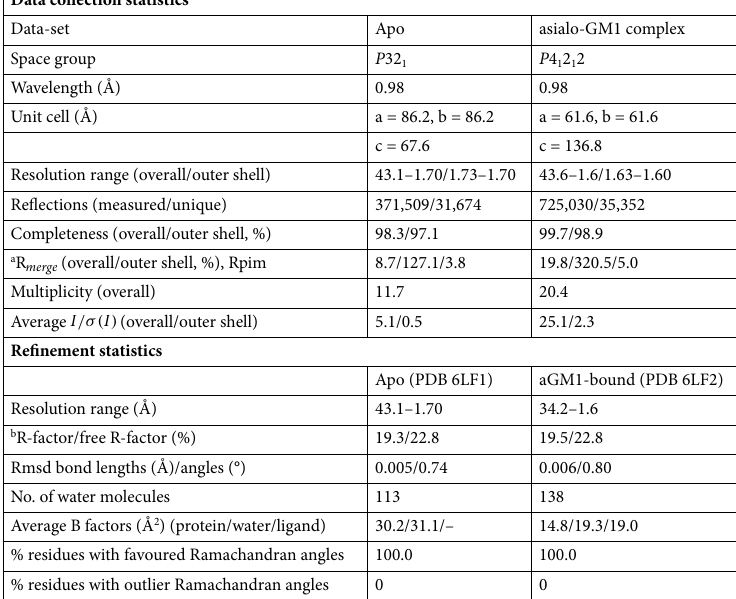
too small for PISA 28 to predict a stable dimer with confidence. Contacts between the two subunits are listed in STable 1. Compared to MytiLec, SeviL is truncated at the C-terminus by 13 residues. These 13 residues form part of the dimer interface in MytiLec, so the two subunits of SeviL are held together by a quite different set of interactions. β -trefoil lectins are often found to be dimeric, but the dimer interactions differ widely in buried surface area and orientation 29 . Within the apo crystal structure, a crystal contact is formed with Arg 26 of the B chain approaching within 3.6 Å of its symmetry mate. Two nearby balls of electron density were modelled as chloride ions, which would counter the repulsive charge on the two residues (SFigure 2). One chloride ion sits in a hydrophobic pocket formed by Phe 21, Phe 32 and Tyr 37; it comes within 3 Å of the side-chain of Asp 39, which also lies close to Arg 26 from the neighbouring molecule. No chloride ions were modelled near the A subunit, and it appears this interaction is unique to the crystal form, which was crystallised at pH 3.5. Comparison with other trefoil lectins. Although SeviL shows only weak sequence similarity to known structural models, using DALI 30 to find structural homologues in PDB with the model of the Sevil subunit yielded a number of significant matches. The closest (with a Z-score of 18.2) is lectin LSL from the mushroom Laetiporus sulphureus (PDB 1W3A) 31 . This is a hexameric pore-forming lectin with an N-terminal β -trefoil domain. The γ subdomain binds the non-reducing galactose (Gal) moiety of lactose. A sequence alignment of SeviL and its closest structural homologues is given in SFigure 3. DALI identified 24 structures with a Z-score of 15 or higher, which are mainly listed as lectins or proteins of unknown function. Several are reported to be insec- ticidal and one is actinohivin, a gp120-binding lectin that is reported to block HIV infection 32 . Strong structural similarity is also seen to the lectin domain of interleukin-33 (PDB 5VI4) 33 , an agonist cytokine that is mainly expressed by epithelial, endothelial and fibroblast cells, and an attractive therapeutic target 34 . Overall however, the sequence and structure of SeviL provide few clues to its biological function.